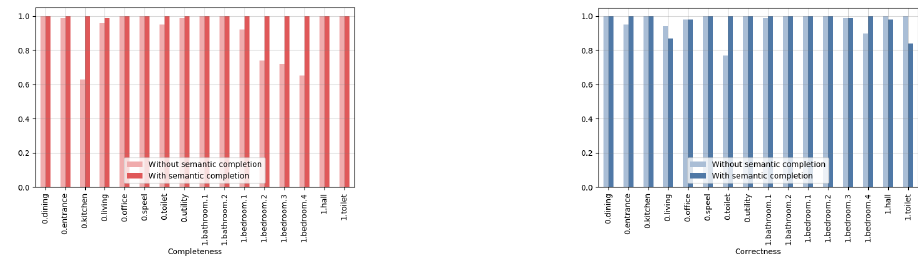
Figure 15. Quantitative comparison of the geometric reconstruction with and without semantic